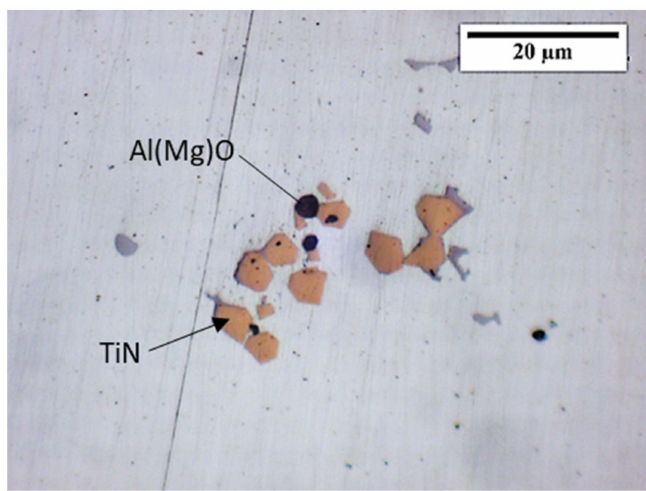
Figure 14. Clustered inclusions of TiN in sample 2, taken with LOM in 100 × magnification.